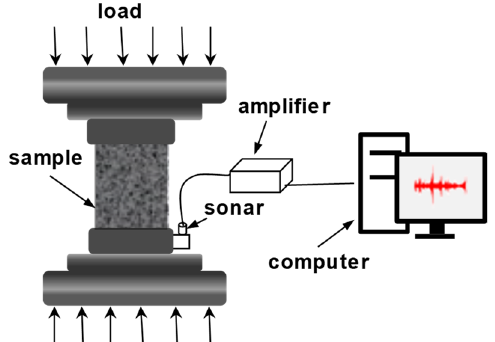
Figure 5. Schematic diagram of experimental setup.